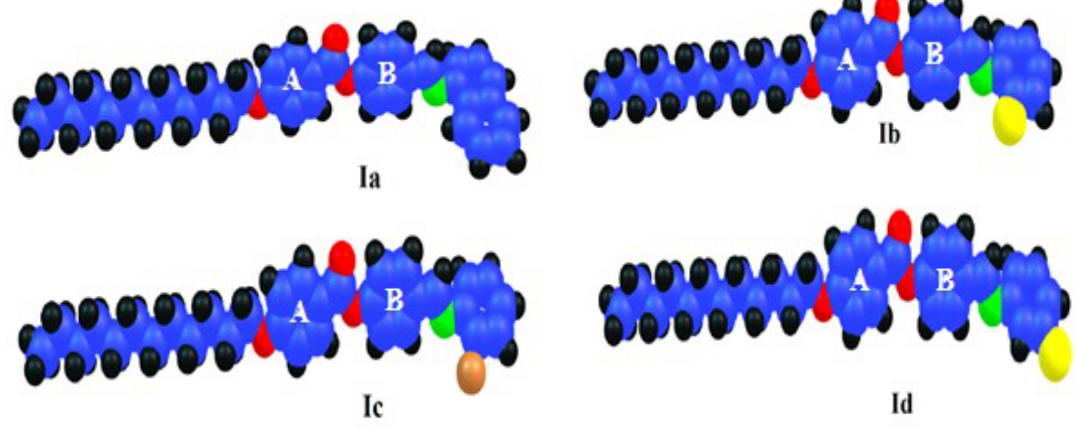
Figure 6. Optimized geometrical structures of Ia–d.